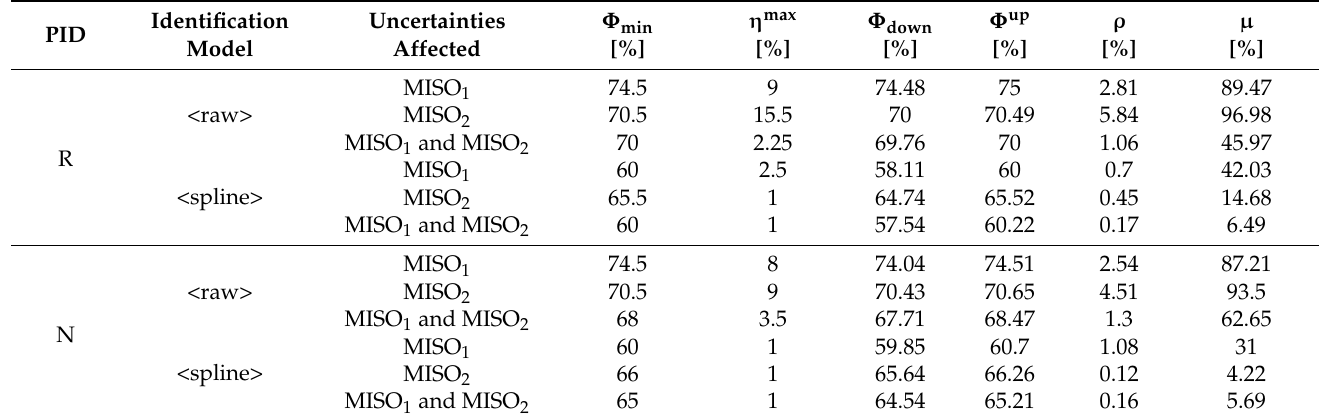
Figure 30. Estimating the robustness margin against uncertainties of the overall ASTANK2 model. Table 8. Parameters of robustness against model